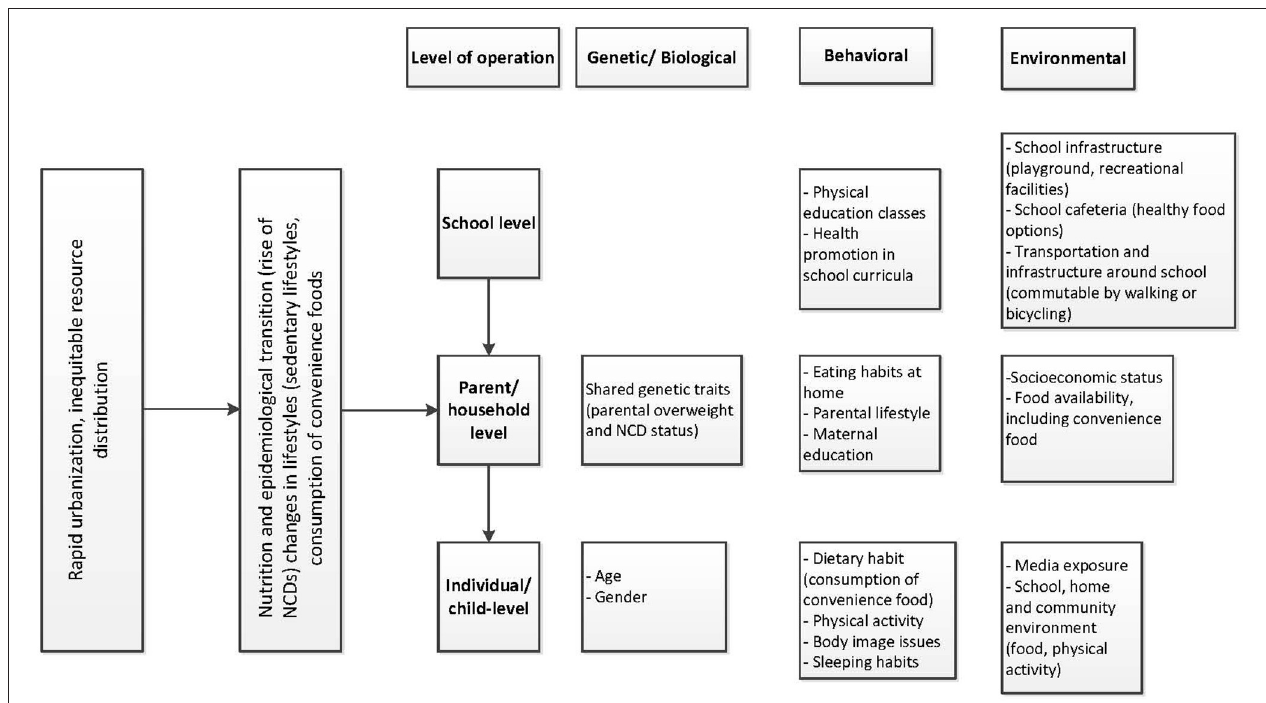
FIGURE 1 | Framework conceptualizing the modifiable risk factors of childhood and adolescent overweight and obesity. Note: The framework is adapted from Kimani-Murage, ( 15) Conceptual framework on nutrition transition and hierarchical organization of factors influencing a child’s nutritional status (15).